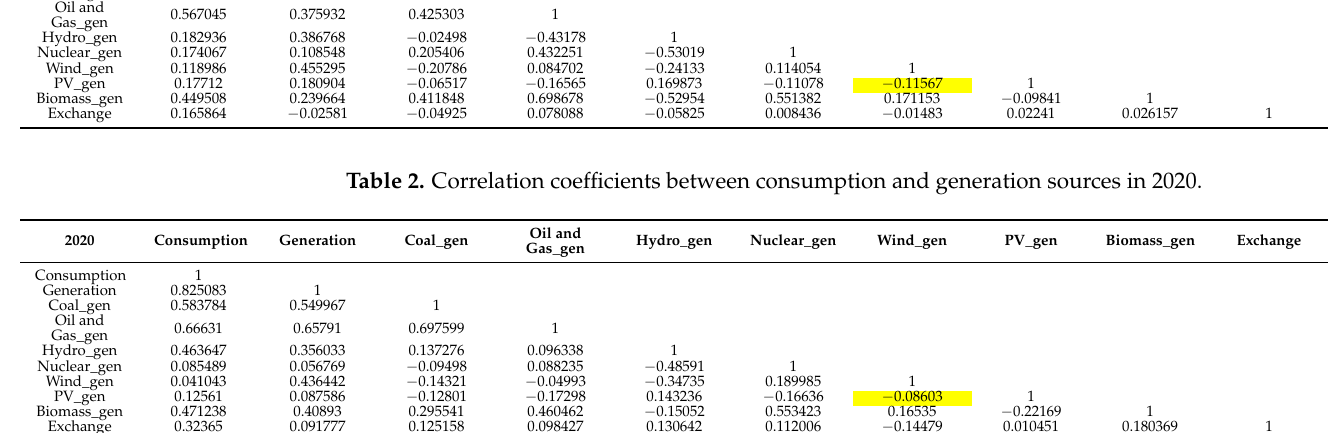
Table 3. Correlation coefficients between consumption and generation sources in